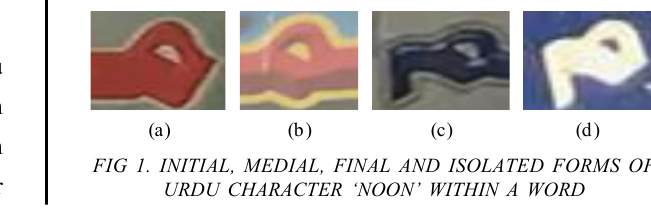
FIG 1. INITIAL, MEDIAL, FINAL AND ISOLATED FORMS OF URDU CHARACTER ‘NOON’ WITHIN A